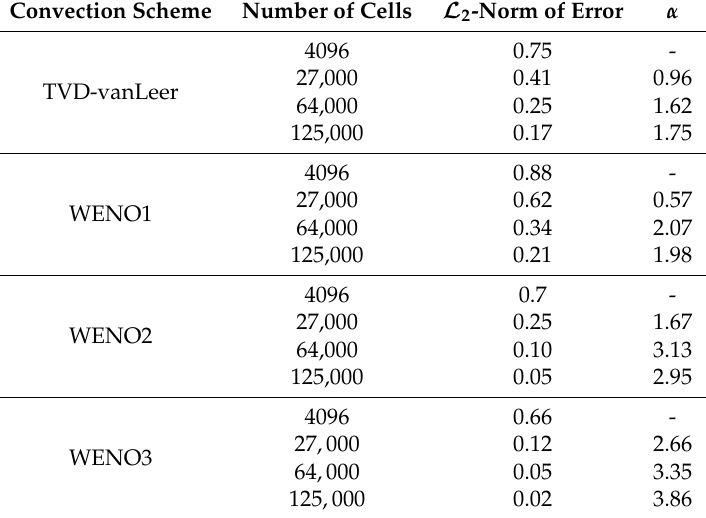
Table 3. Error and convergence of WENO convection schemes for the advection equation on hexahedral meshes.